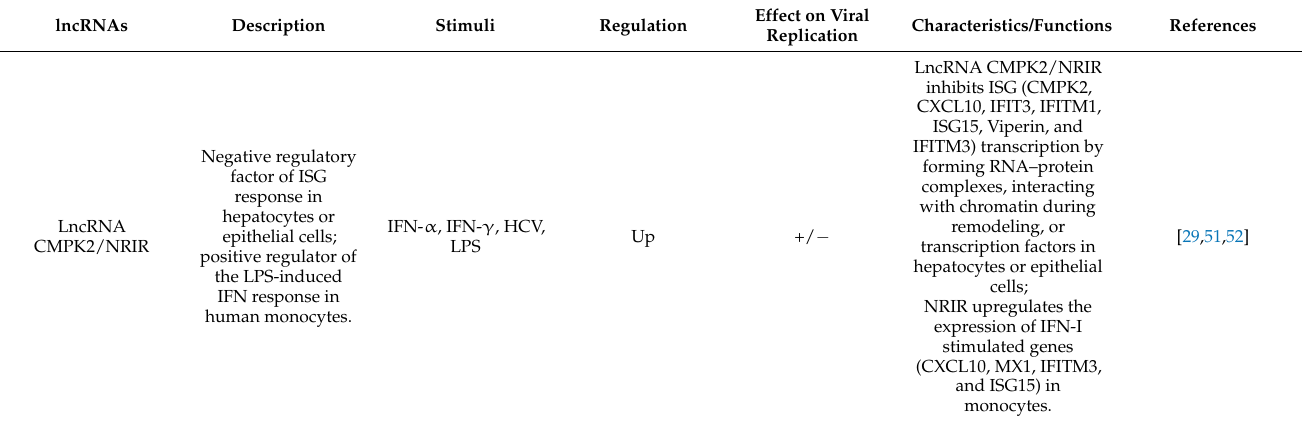
Table 1. Interferon (IFN)-induced lncRNAs act as ISGs and are involved in the host antiviral innate immune